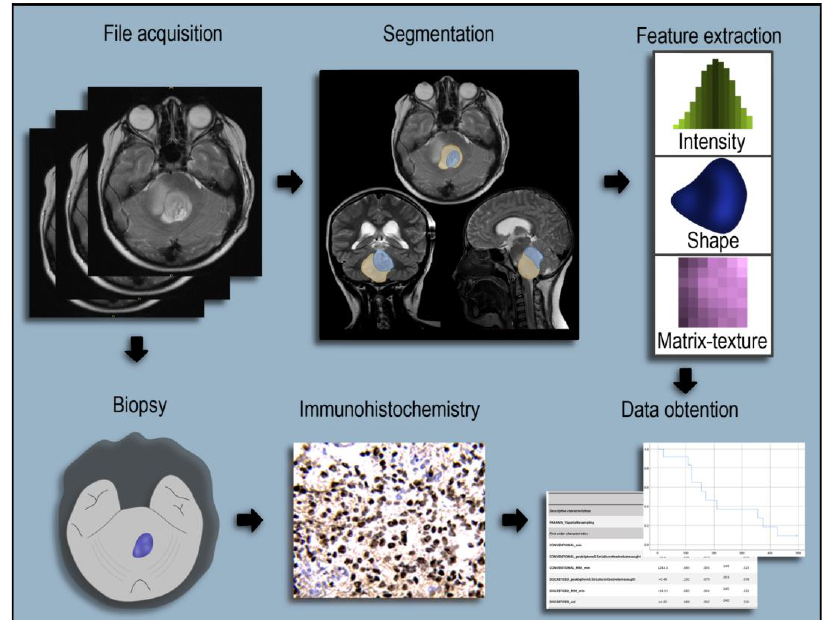
Figure 3. Description of steps followed for the data acquisition of patients. In the initial stage, pa- tients underwent MRI imaging studies that showed pathological lesions compatible with DMG. This assessment was followed by histopathological diagnostic and nuclear immunostaining with recog- nition of the mutated H3F3A K27M protein. Segmentation of the tumour regions was performed.